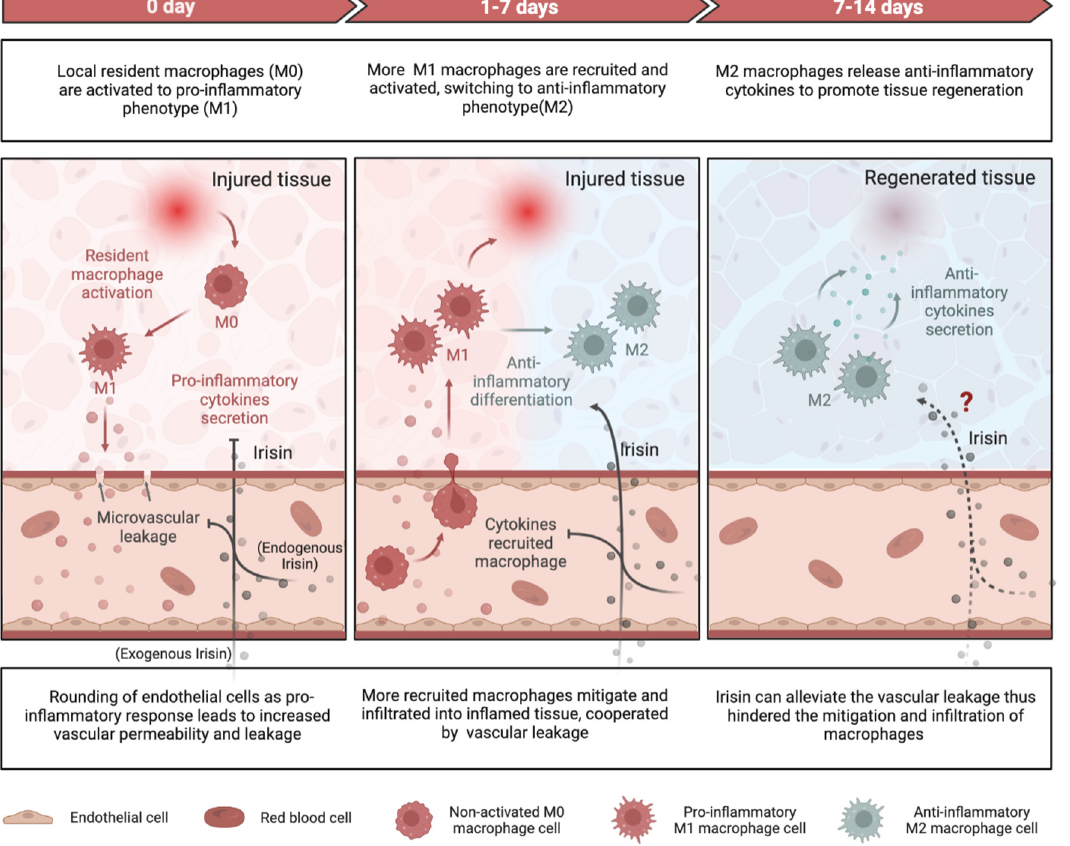
Figure 2. Schematic representing the anti-in fl ammatory function of Irisin during tissue repair. At the beginning of tissue repair, local resident macrophages (M0) are activated to pro-in fl ammatory phenotype (M1) macrophages, which release pro-in fl ammatory cytokines such as IL-6, IL-1 β , and TNF- α , and change the endothelial to round-like shape, hence increase the vascular permeability and cause vascular leakage bene fi ting the mitigation and recruitment of more pro-in fl ammatory macrophages form peripheral blood into in fl amed tissue. Irisin can blunt this acute-phase in fl am- matory response via downregulating pro-in fl ammatory cytokines and reducing vascular permea- bility. Furthermore, Irisin has been proven with the ability to stimulate anti-in fl ammatory macro- phages (M2) polarization from M1, resulting in elevated anti-in fl ammatory cytokines secretion. However, it remains to be determined if Irisin directly mediates the M2 macrophages.